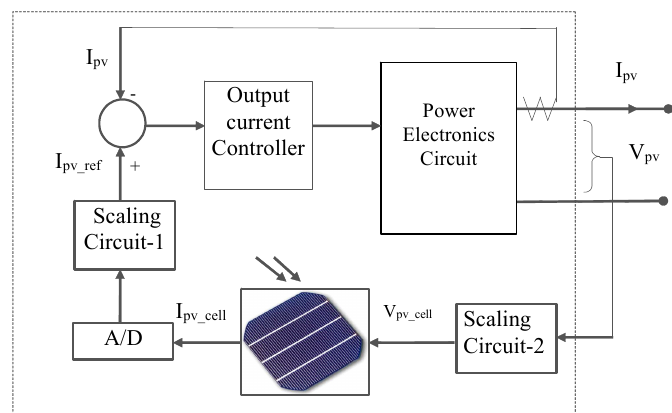
Figure 10. Block diagram of an actual solar cell characteristics based PV simulator [22].